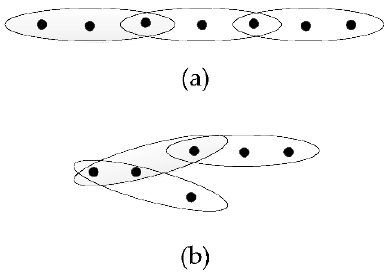
Figure 10. The non-linear variation (shown as ( b )) is from the 3-uniform GHT (shown as ( a )), and the Figure 10. The non ‐ linear variation (shown as ( b )) is from the 3 ‐ uniform GHT (shown as ( a )), and Figure 10. The non ‐ linear variation (shown as ( b )) is from the 3 ‐ uniform GHT (shown as ( a )), and Figure 10. The non ‐ linear variation (shown as ( b )) is from the 3 ‐ uniform GHT (shown as ( a )), and number of vertices of ( b ) is 1 less than that of ( a the number of vertices of (b) is 1 less than that of (a). the number of vertices of (b) is 1 less than that of (a). the number of vertices of (b) is 1 less than that of (a).